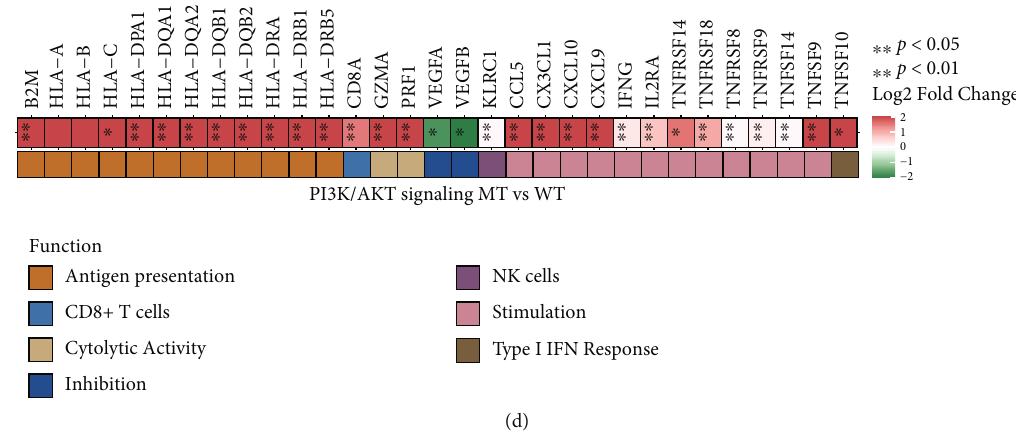
Figure 4: The relationship between PI3K/Akt mutations and immune microenvironment. (a) CIBERSORT comparison of the content of 22 types of immune cells in the tumor microenvironments of PI3K/Akt-MT and PI3K/Akt-WT patients (algorithm running the lm22 signature and 1,000 permissions). (b) Di ff erence in immune checkpoint gene expression between the PI3K/Akt-WT and PI3K/Akt-MT groups. (c) Di ff erence in immune fractions between the PI3K/Akt-WT and PI3K/Akt-MT groups. (d) The functions of immune module genes involved in the PI3K/Akt pathway, including antigen presentation, CD8+ T cells, cytologic activity, inhibition, NK cells, stimulation,